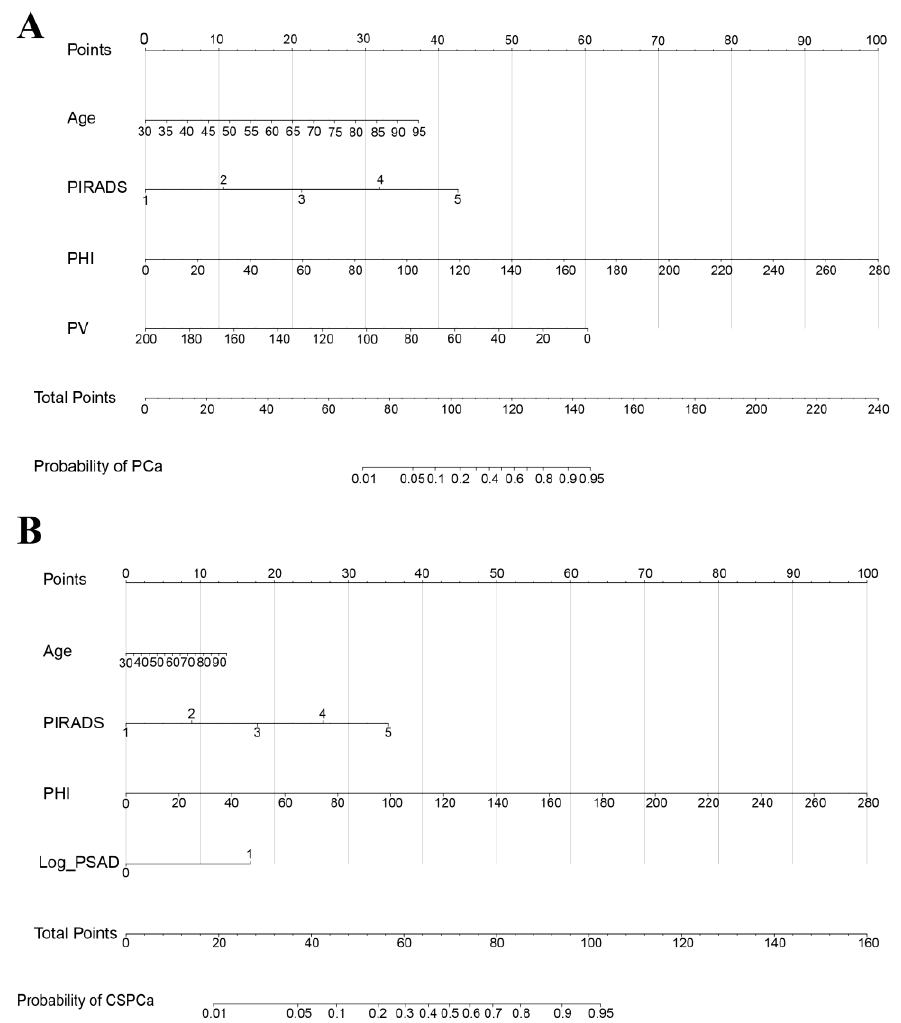
Figure 1. Nomograms for PCa ( A ) and CSPCa ( B ). In order to determine the point of each variable, draw a vertical line from the corresponding axis of the variable to the points axis. To estimate the probability of PCa/CSPCa, the total score can be projected to the lower total point axis by summing the points for each variable. PIRADS: Prostate Imaging-Reporting and Data System; PHI: prostate health index; PV: prostate volume; PSAD: prostate-specific antigen density; PCa: prostate cancer; CSPCa: clinically significant prostate cancer, defined as Gleason Grade ≥ 2.